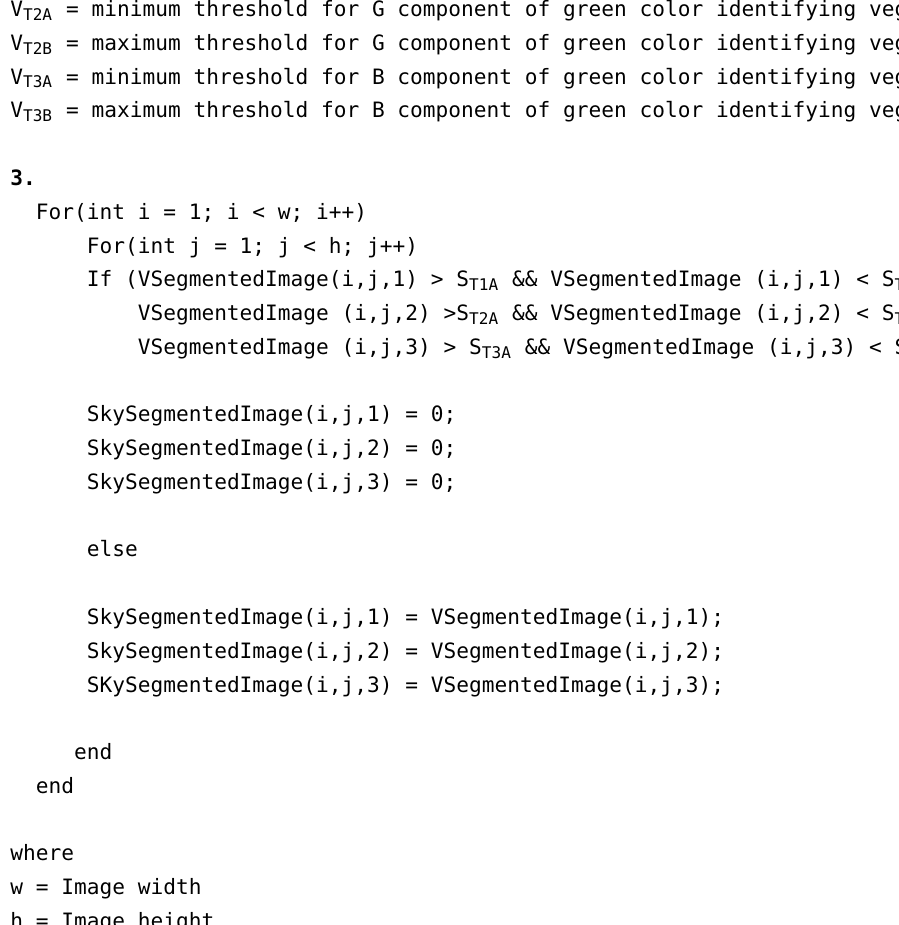
S T1A = minimum threshold for R component of blue and white color identifying sky S T1B = maximum threshold for R component of blue and white color identifying sky S T2A = minimum threshold for G component of blue and white color identifying sky S T2B = maximum threshold for G component of blue and white color identifying sky S T3A = minimum threshold for B component of blue and white color identifying sky S T3B = maximum threshold for B component of blue and white color identifying sky